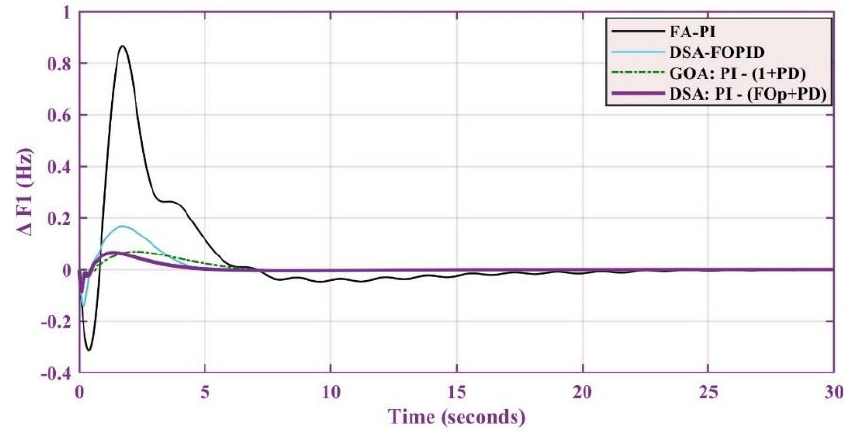
Figure 9. Response at 2.5% load change for area-1 .